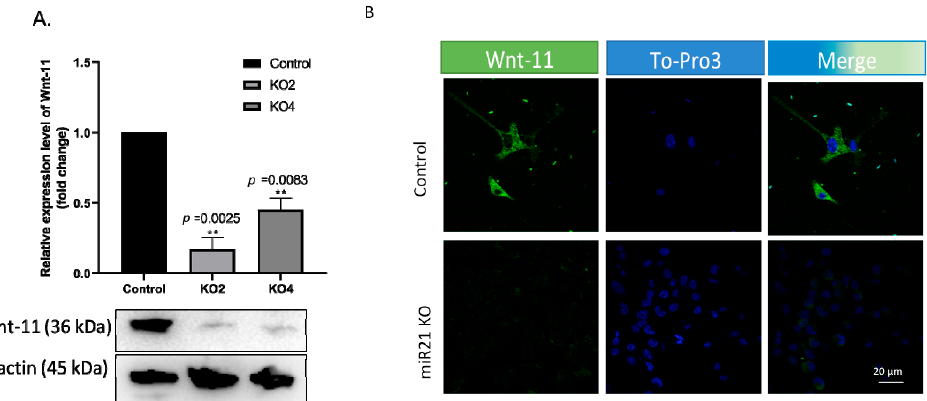
Figure 6. miR-21 deletion downregulated Wnt-11 expression in MDA-MB-231 cells. ( A ) The Wnt-11 expression was examined by Western blot analysis in MDA-MB-231 wt and two selected colonies for miR-21 KO cells. β -actin was used as a loading control. The densitometry graph represents protein expression levels of band intensities obtained from at least three independent experiments. The relative band intensities of each sample were calculated by normalizing against β -actin. Each data point represents average ± SD. ** p < 0.01. ( n = 3) ( B ) The Wnt-11 expression was examined by immunofluorescence, and ToPro3 (blue) was used for nuclei. Clone 2 (KO2) immunofluorescence results were shown as a representative to compare to wt ( n = 3), scale bar 20 nm.